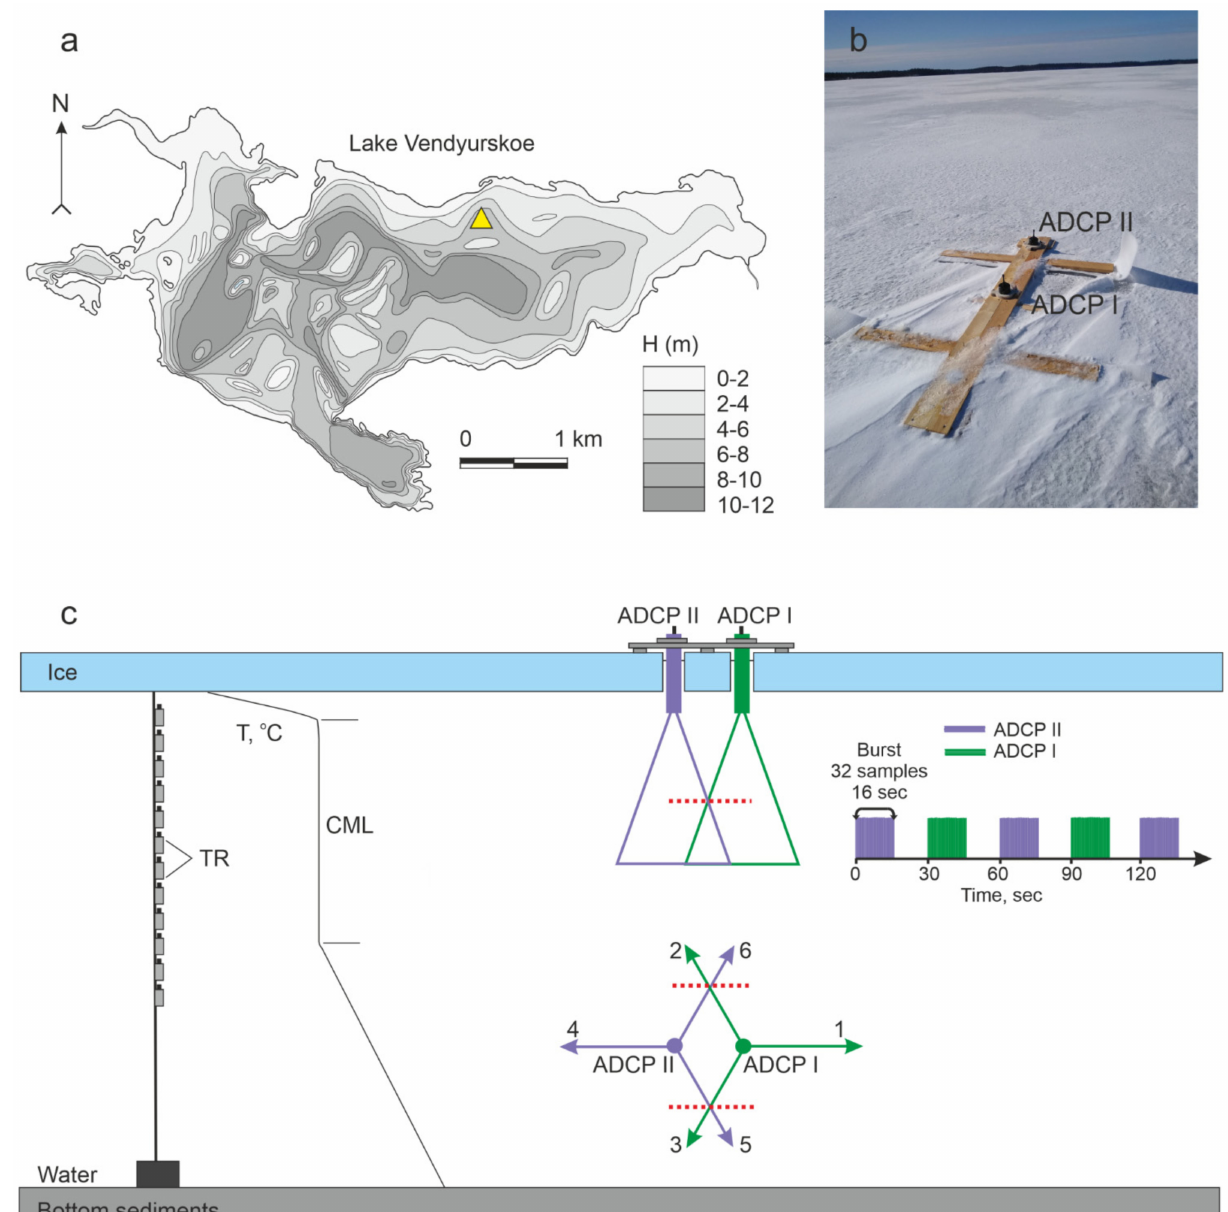
Figure 2. ( a ) Bathymetry of the Lake Vendyurskoe with indication of the measuring complex (yellow triangle). ( b ) Two ADCPs anchored on the ice of Lake Vendyurskoe in Spring 2020. ( c ) Schematic vertical distribution of temperature during springtime underice convection and scheme of the measuring complex. Indexes 1, 2, 3—the beams of the first ADCP, and 4, 5, 6—the second. Red dashed lines serve as the markers of beams’ intersection